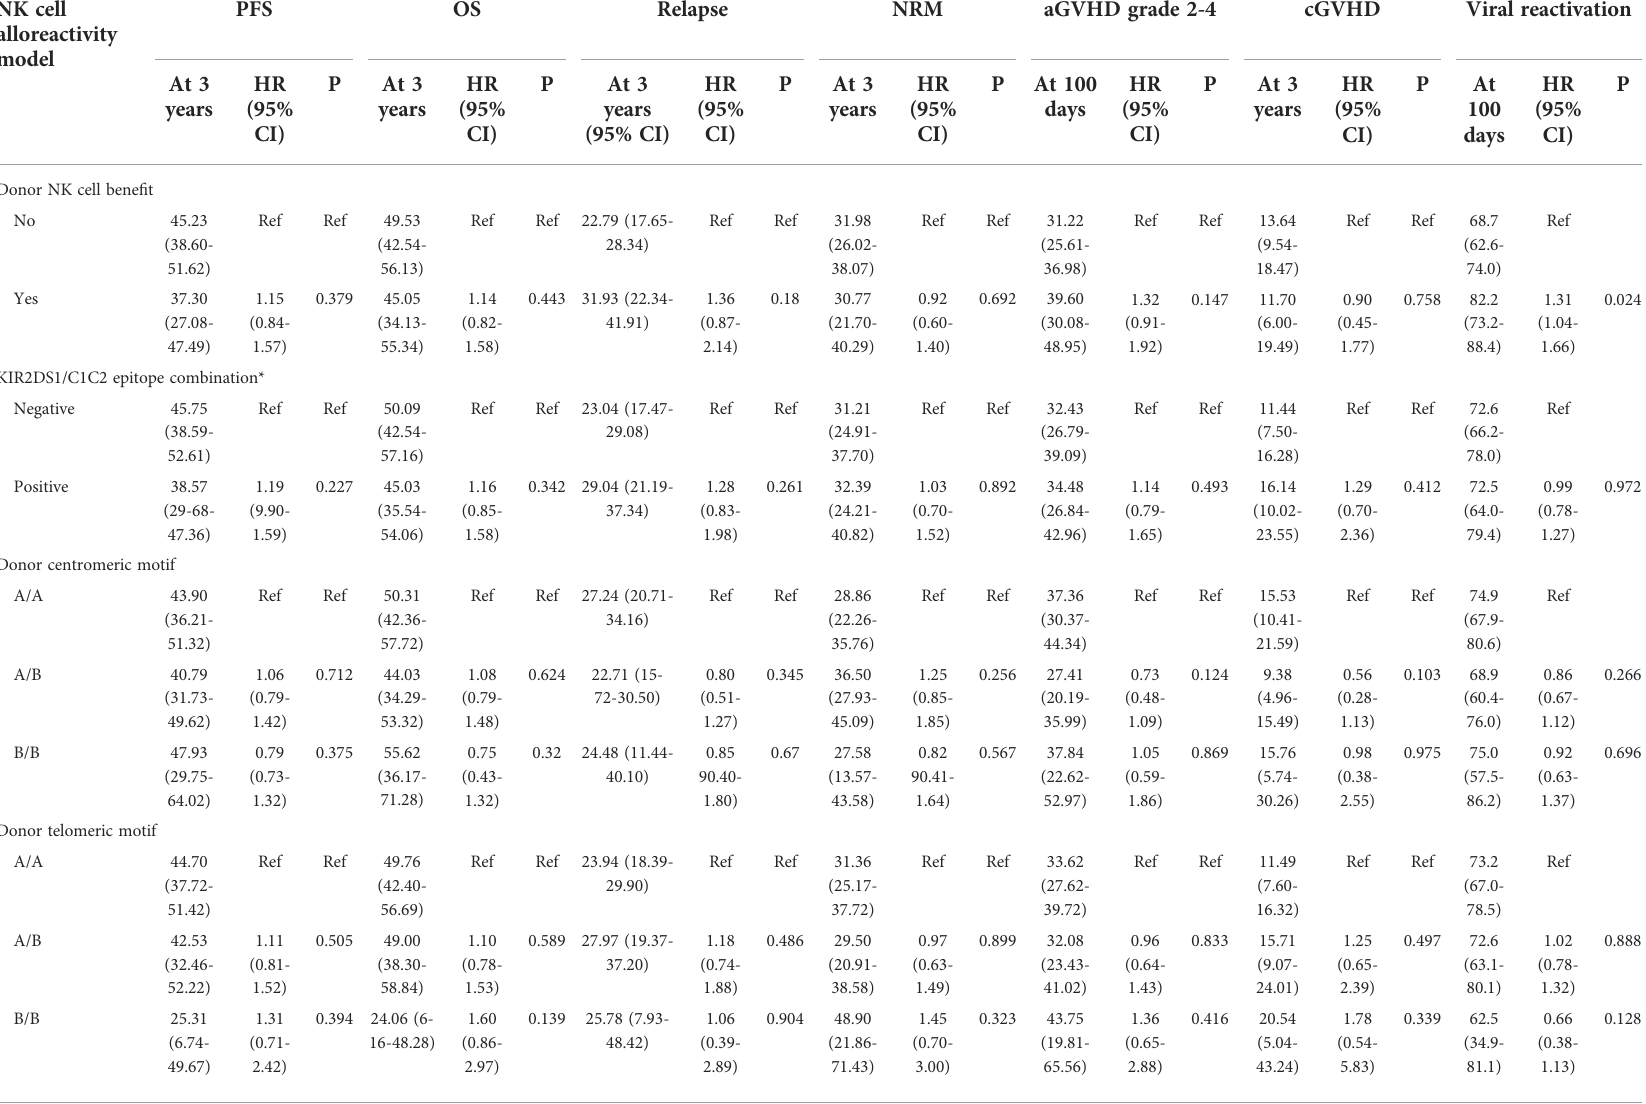
TABLE 2 Univariate analysis of the effect of NK cell alloreactivity predicted by different models on haploidentical HSCT outcomes in our cohort (n =